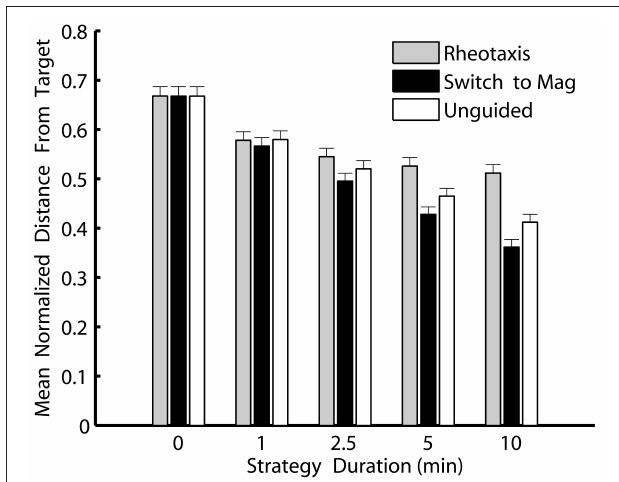
Figure 4 | Switching to a magnetic compass sense is consistently the best strategy for simulated T. diomedea that lose contact with an odor plume due to flow heading changes. Shown are minimum distances that simulated slugs reached relative to an odor source for each of three strategies invoked over five different durations after an odor plume was no longer detected. Values are means normalized to the initial distance from the source, with standard errors. Strategies: continued rheotaxis (gray), switching to a magnetic compass to crawl along the last heading from which odor was detected (black), and unguided crawling initiated along the last heading from which odor was detected (white). Over all non-zero durations, switching to magnetically guided crawling was consistently the best strategy. The zero duration strategies (which are the same for all three strategies types since, in all three cases, the strategy is strict odor-gated rheotaxis followed by no subsequent strategy) were the worst strategies for finding the odor